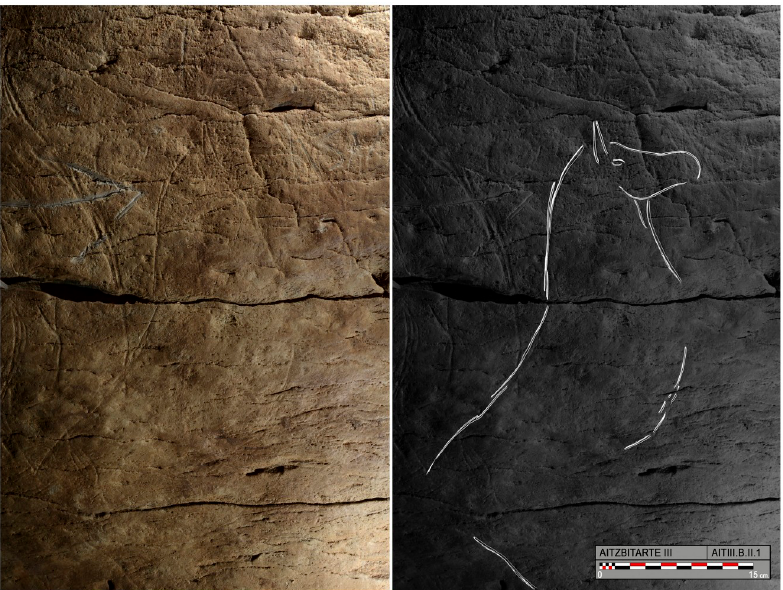
Fig 6. Photograph and tracing of horse B.II.1, engraved on the right-hand wall in Aitzbitarte Cave III (O. Rivero and D. Garate).